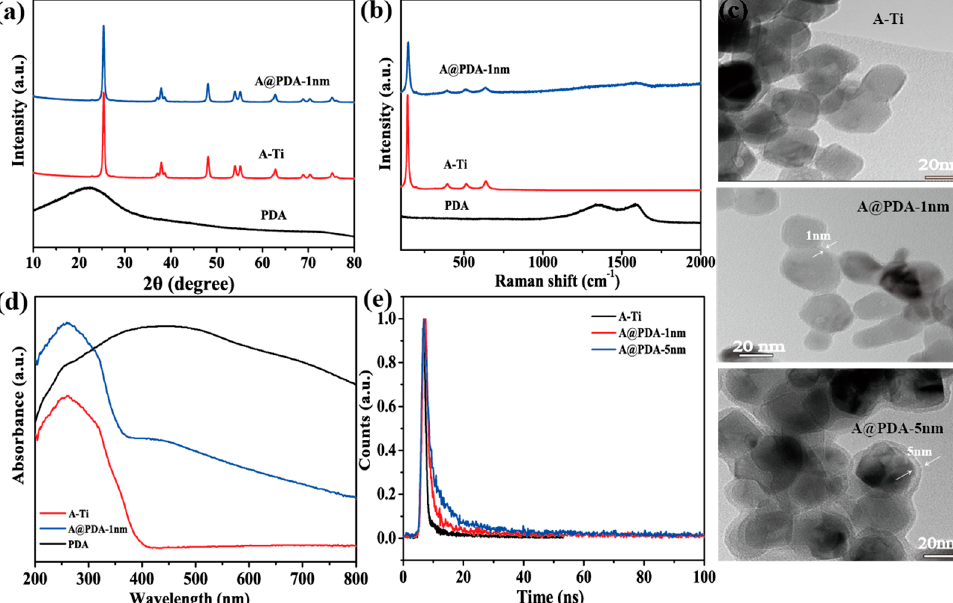
Figure 1. ( a ) XRD pattern and ( b ) Raman spectra of A@PDA-1 nm, A-Ti and PDA; ( c ) TEM images of A-Ti, A@PDA-1 nm, and A@PDA-5 nm; ( d ) UV-vis diffraction reflectance spectra of A-Ti, A@PDA-1 nm, and PDA; and ( e ) PL decay spectra of A-Ti, A@PDA-1 nm, and A@PDA-5 nm. Table 1. Specific surface area, mean pore size and pore volume of the photocatalysts. Photocatalyst